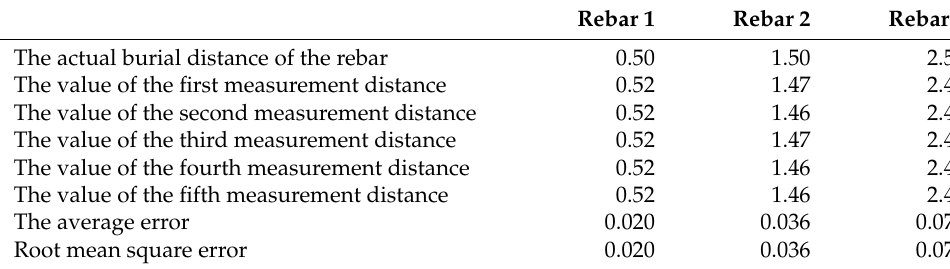
Figure 15. Target location results of ground-penetrating radar images. We used the real-time detection system along the detection direction to repeat the test five times. The comparison of the results regarding the detection of rebar along the detection line direction from the GPR detection starting point’s location and the actual burial distance is shown in Table 2, while the comparison of the results obtained by the real-time detection system regarding the detection of the buried depth of the rebar and the actual buried location is shown in Table 3. Table 2. Comparison of the distance between the steel bar detected by the ground-penetrating radar real-time detection system and the actual buried distance (unit/m).